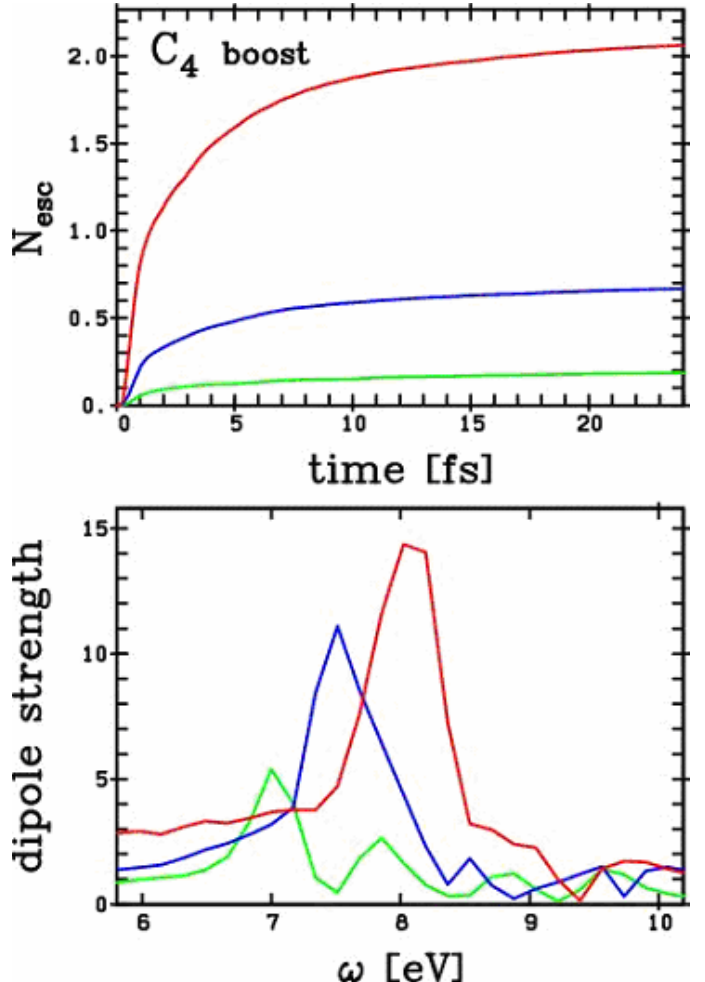
Figure 3 : Optical response (lower panel) and ionisation (upper panel) of a C various strengths of excitation. The initial boost placed the following amounts of energy into the cluster: green = 0.3 Ry, blue = 1.3 Ry, and red = 5.1